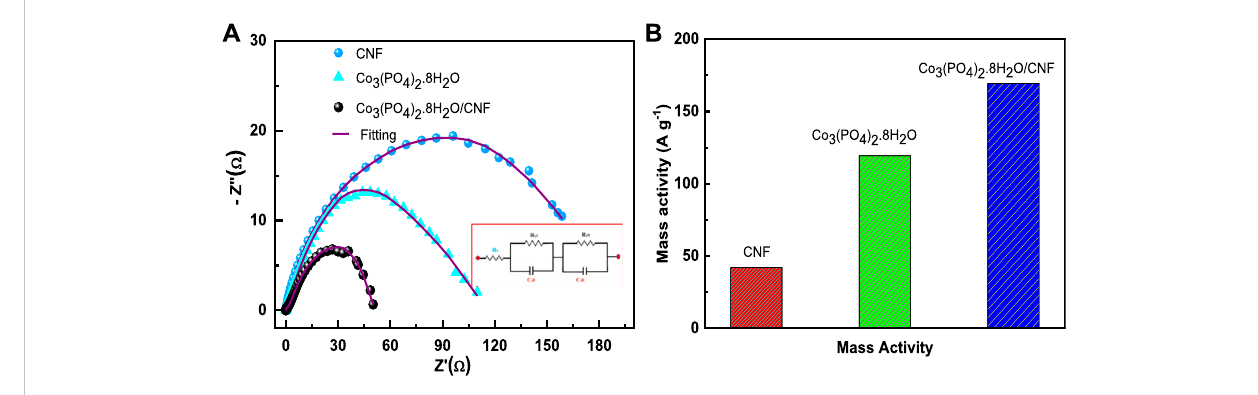
FIGURE 8 (A) Electrochemical impedance spectroscopy (EIS) plots and (B) mass activity of the catalysts.